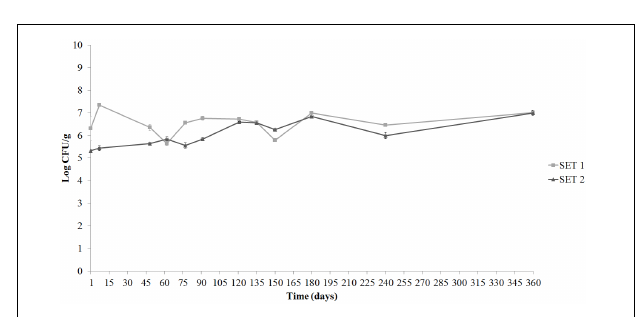
FIGURE 5 | Evolution of mesophilic bacteria in Spanish-style olives pulp packaged in PTE bags and stored at 4 ◦ C: SET1 (bio-preserved), and SET2 (control). Means and standard deviations were obtained from measurements made in duplicate packages from two different experiments ( n = 4).